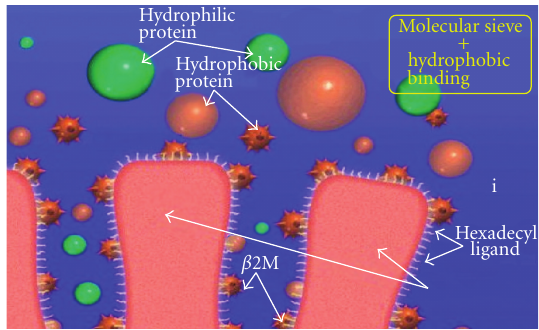
Figure 7: The schema of the Lixelle column. The Lixelle column is designed to adsorb β 2-MG selectively by combined use of hydro- phobic interaction and adequate pore